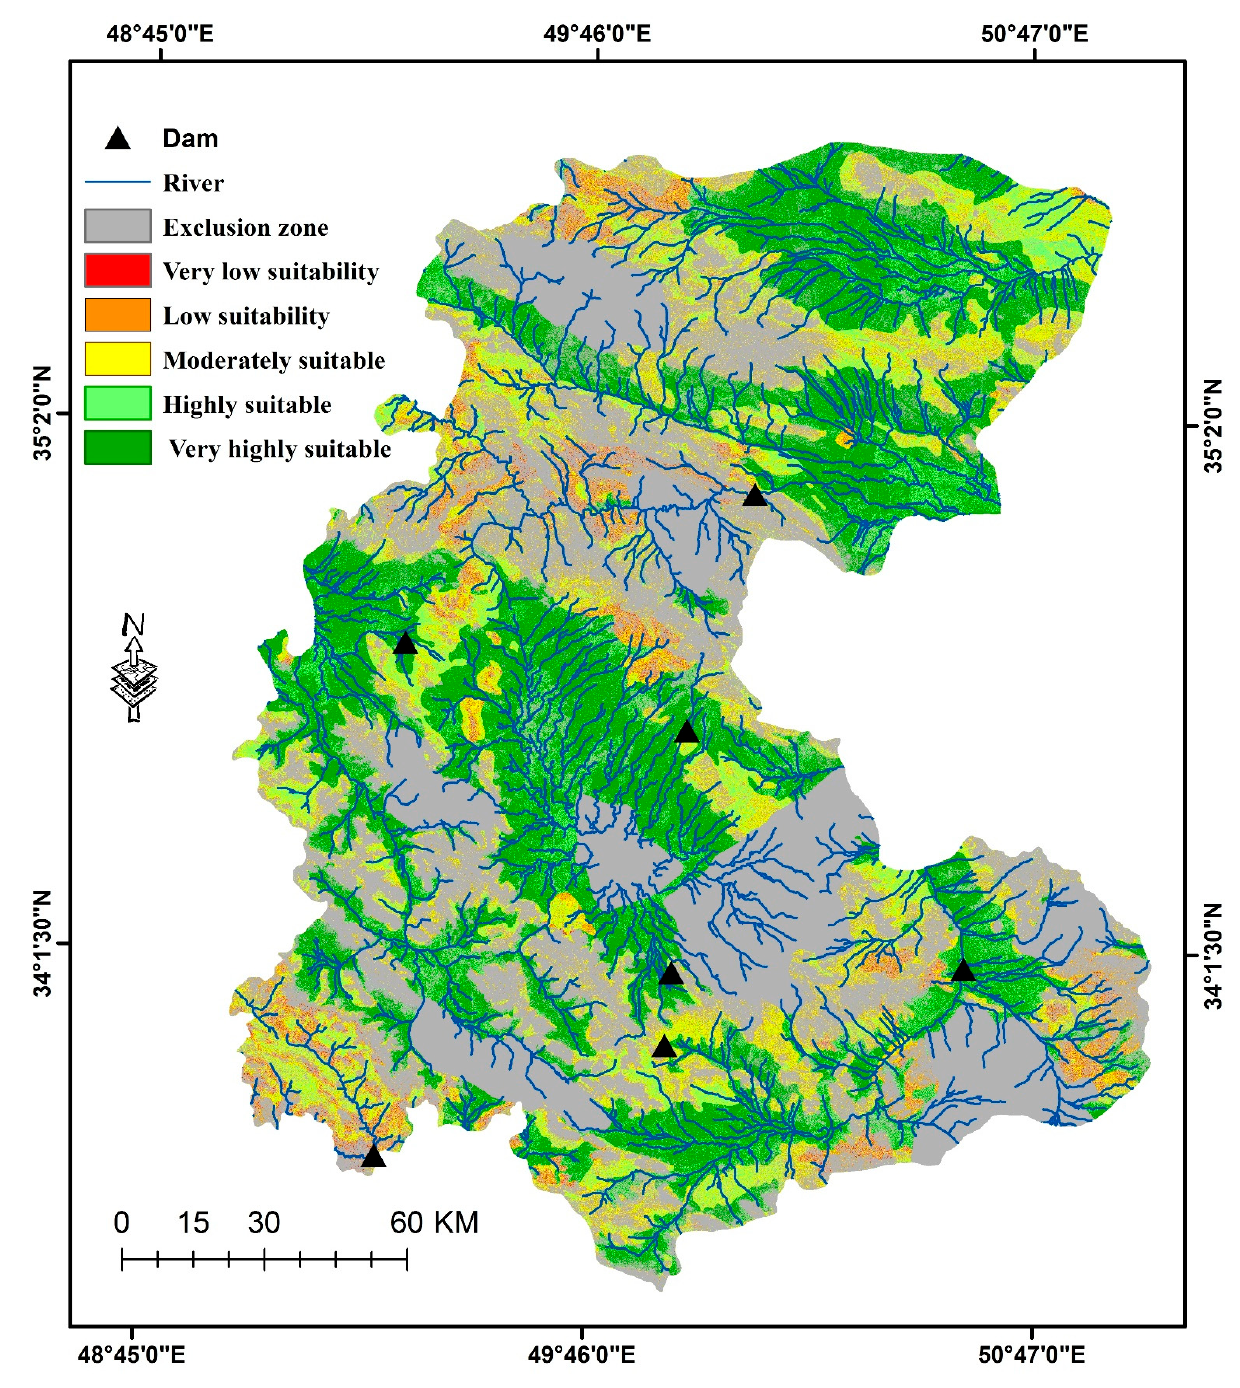
Figure 7. Land potential for suitable aquaculture development of Oncorhynchus mykiss (rainbow trout) in Markazi province integrated with the limitation map findings.